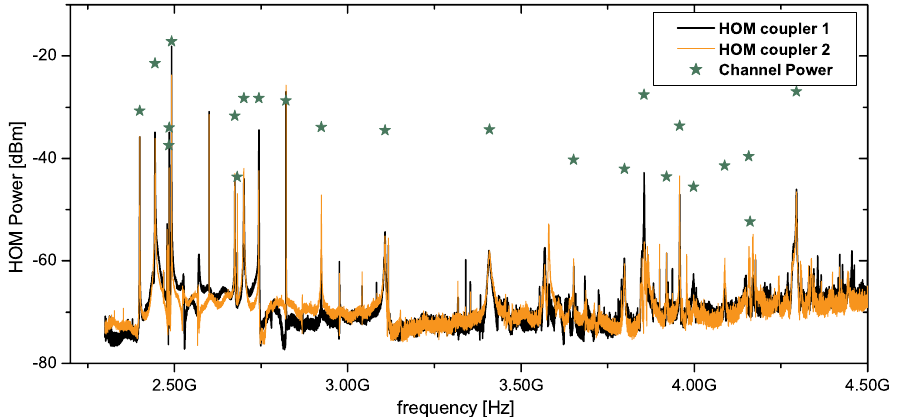
FIG. 5. HOM spectra of both HOM couplers and total channel power of dominant HOM frequencies, measured at a beam current of 500 nA and a bunch charge of 120 pC, respectively.